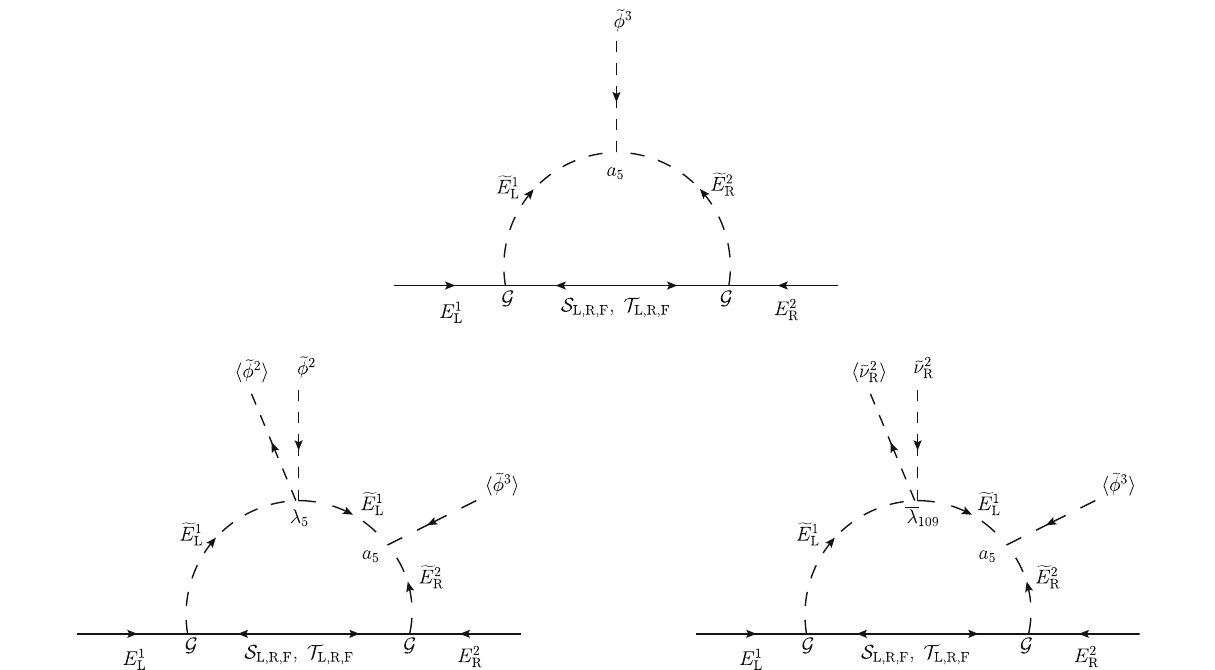
Fig. 6 One-loop diagrams contributing to the radiative generation of κ κ (cid:3) (bottom-left diagram) and κ (cid:3)(cid:3) 1 (top diagram), 1 gram) VLL Yukawa interactions. The Yukawa coupling G is equal to